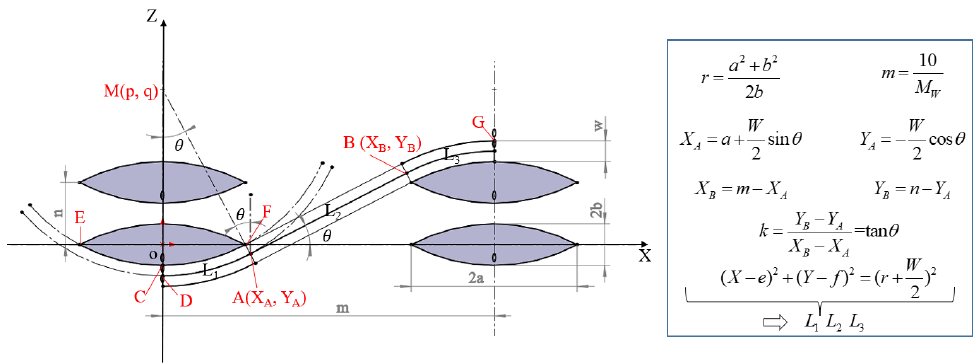
Figure 2. Method for calculating length of curved segment of binder yarn [48].